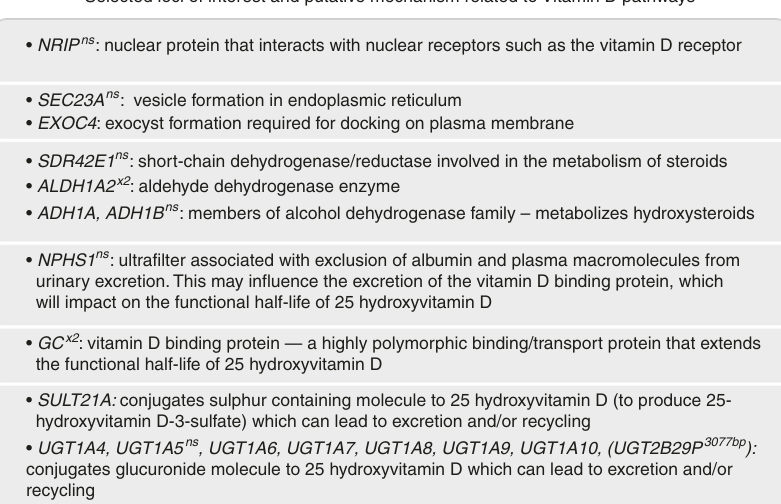
Fig. 4 Summary of selected variants associated with 25OHD in the UK Biobank. Top panel shows loci associated with skin integrity, lipid and lipoprotein pathways and CYP450 and steroid-associated enzymes. Lower panel shows selected variants and putative mechanisms related to 25-hydroxyvitamin D (25OHD) concentration. For selected inter-genic loci, the nearest (upstream or downstream) gene is shown in brackets. The distance between the loci and the nearest gene is shown in base pairs. *CYP24A1 was also the closest gene for an additional three inter-genic loci with distances between 32,865 – 55,282 base pairs. ns non-synonymous variant, x2 or x3 two or three loci found within the gene. We note that nearest gene annotation should be interpreted recognising that these are not proof of a causal relationship between the associated SNP and expression of the gene (none-the-less supporting evidence for causal relationships is given by the SMR analyses for some